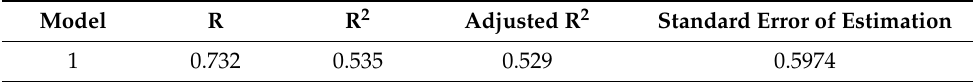
Table 18. Model summary.